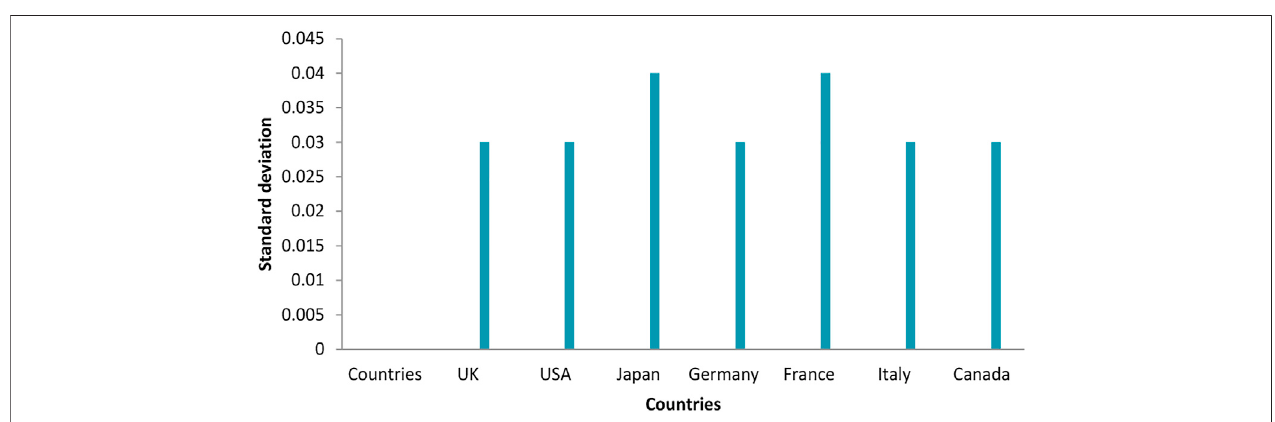
FIGURE 3 | Sensitivity analysis standard deviation